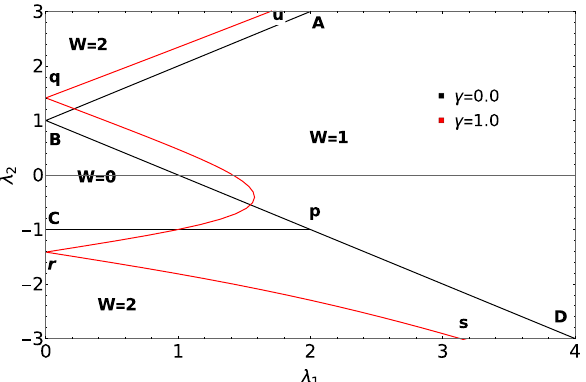
Figure 1. Phase diagram of the model Hamiltonian in presence of γ ( = 1.0 ) . Solid black lines corresponds to the topological phase diagram for γ = 0.0 (Hermitian